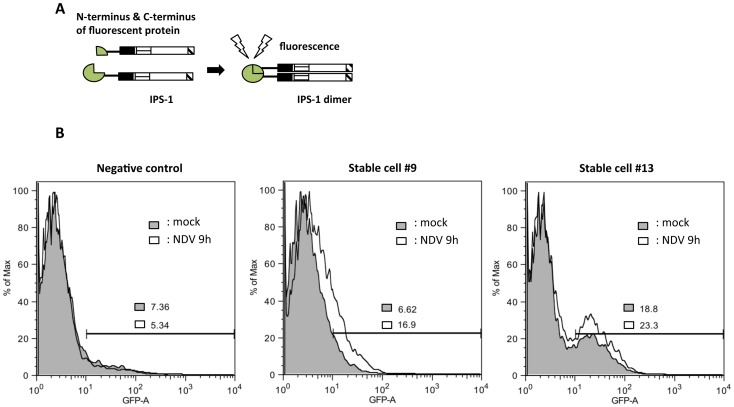
Viral infection induces the molecular oligomer of IPS-1.A. Schematic representation of dimers detection by mKG-tagged IPS-1. B. Flow cytometry plots of control 293T cells and 2 clones stably expressing mKG-tagged IPS-1, #9 and #13. The cells were mock treated or infected with NDV for 9 h. Cells exhibiting fluorescent intensity >101 were quantified and expressed as % of total cell number.